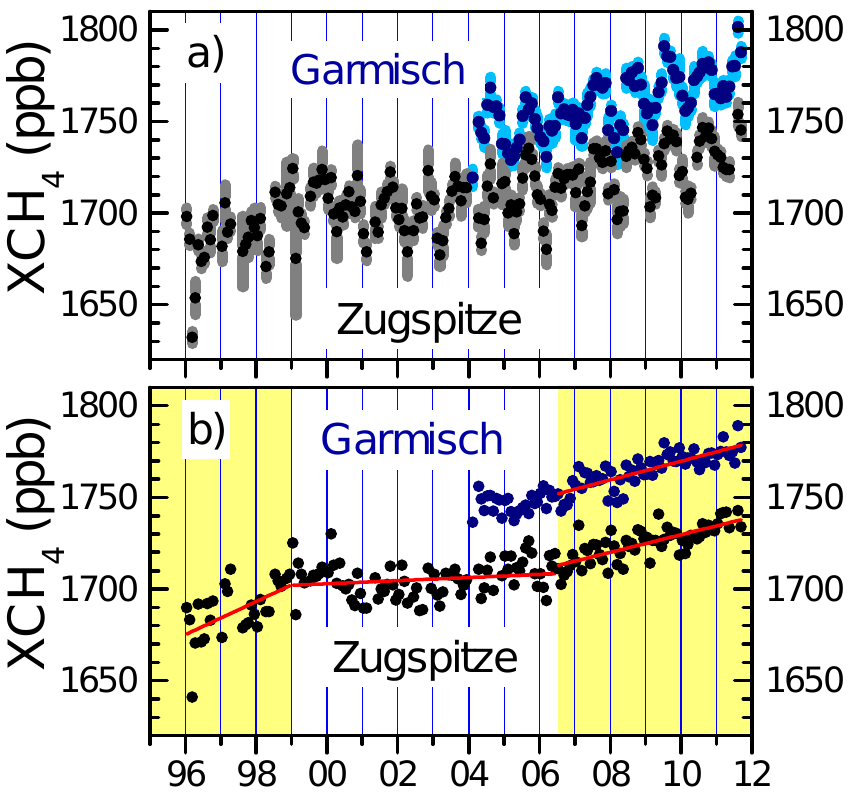
Fig. 1. (a) Time series of methane column-averaged mole fractions above Zugspitze and Garmisch (monthly means). Shaded bars indicate the statistical error of the monthly means calculated from the individual measurements ( ± 3 σ / sqrt ( n) ), where n is the number of FTIR measurements per month. (b) De-seasonalized time series and linear trends (red lines). See Table 2 for trend magnitudes and